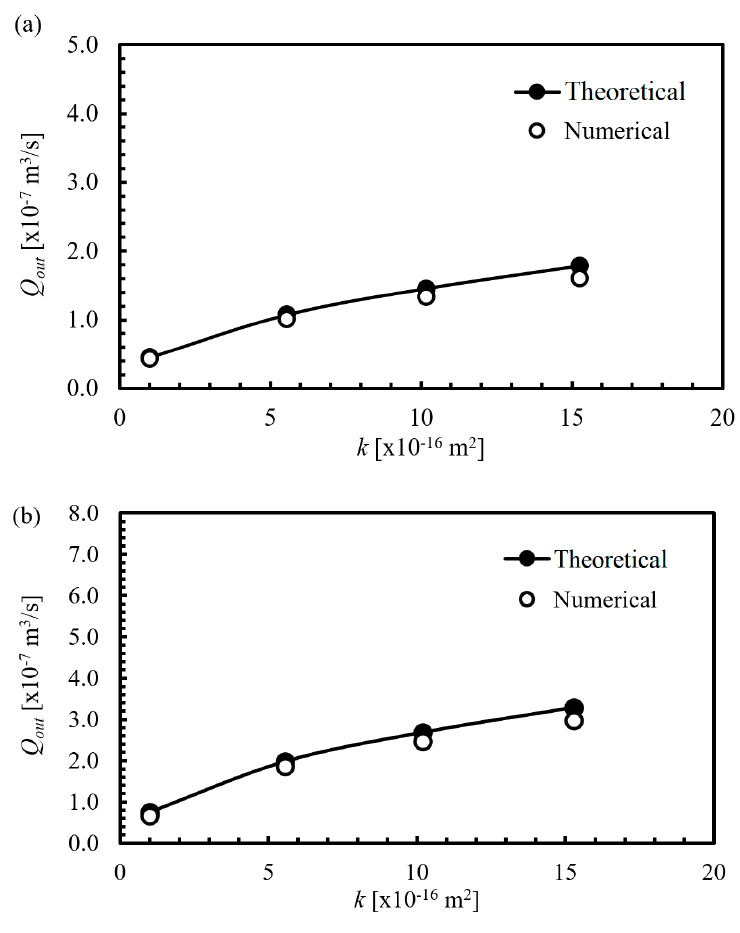
Figure 12. Comparison between the theoretical and numerical output flow rates for fibres with 0.3 mm inner diameter, 0.1 mm membrane thickness. ( a ) Single-end suction; ( b ) Double-end suction.